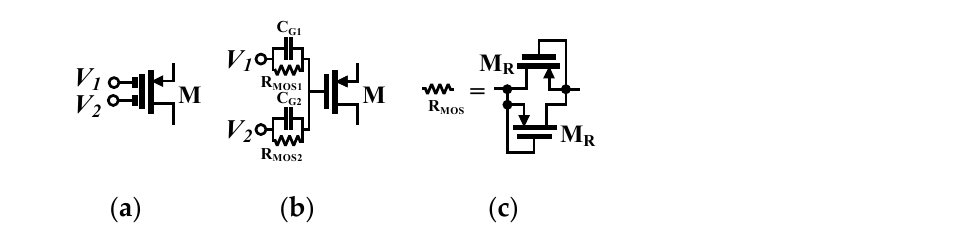
Figure 4. The CMOS structure of the VD-DIBA.